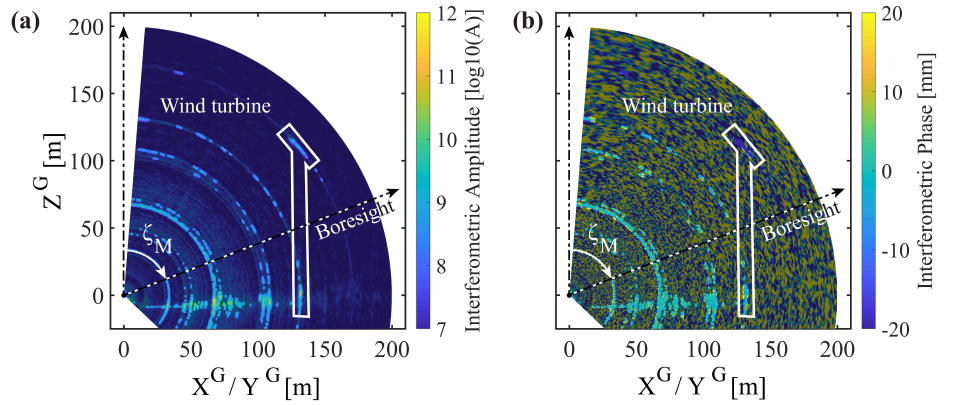
Figure 4. Example of ( a ) an interferometric amplitude image and ( b ) an interferometric phase image for a period of 30s. For a simpler interpretation, both images are overlayed with a mask, darkening areas with coherence in a 3 × 3 neighborhood of less than 0.85, as well as outlining the location of the wind turbine and the direction of the antenna